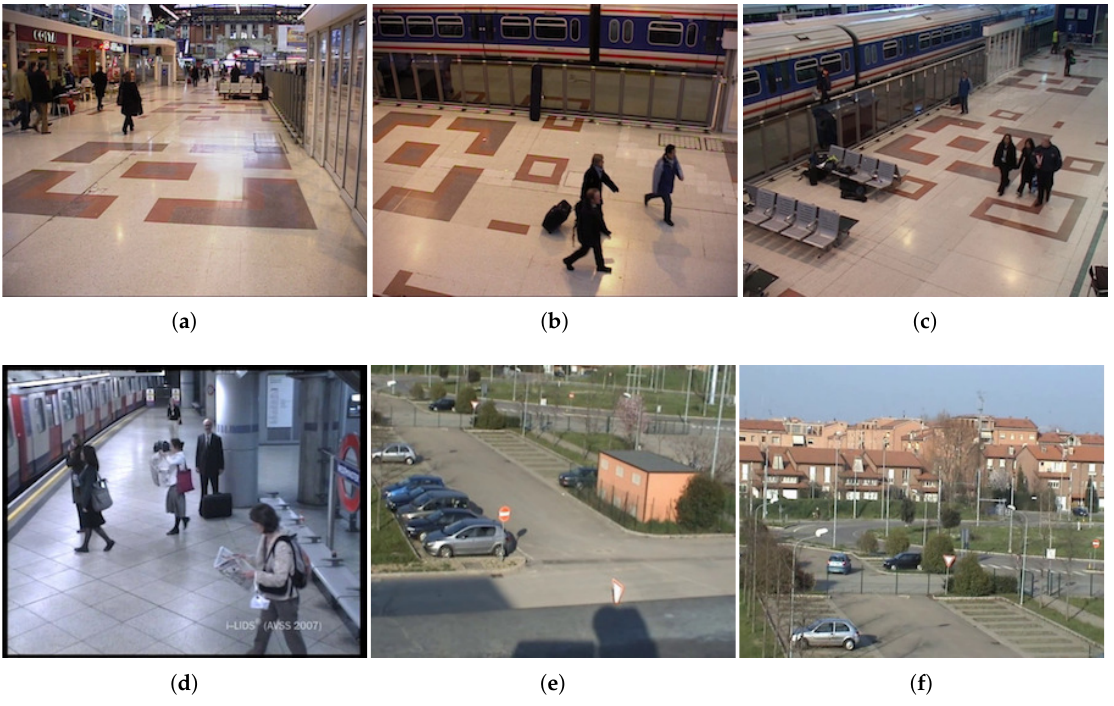
Figure 9. Sample frames from: ( a ) PETS 2006 camera 1, ( b ) PETS 2006 camera 3, ( c ) PETS 2006 camera 4,